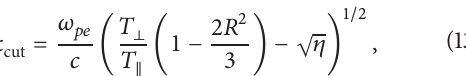
𝑅 = ℏ𝑘/2𝑚 V 𝑒 𝑡‖ , for